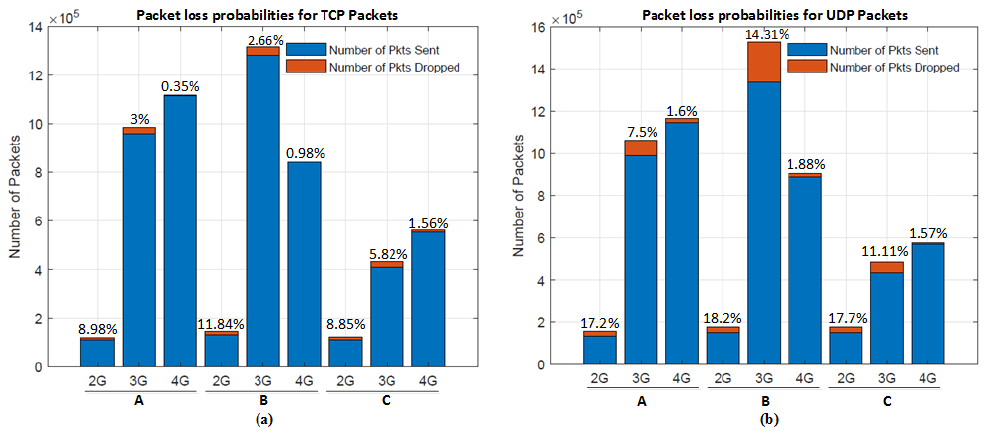
Figure 3. Packet loss probabilities measured for ( a ) TCP and ( b ) UDP-based packets using three cellular networks in